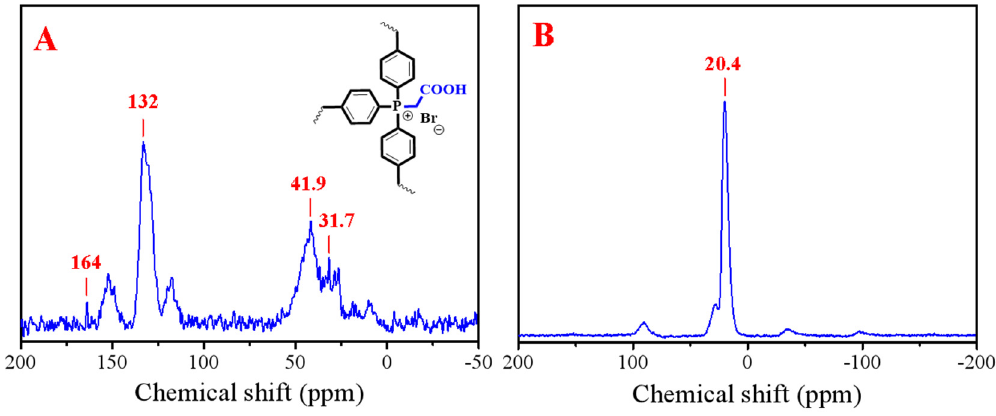
Figure 1. ( A ) 13 C and ( B ) 31 P solid state NMR spectrum of the